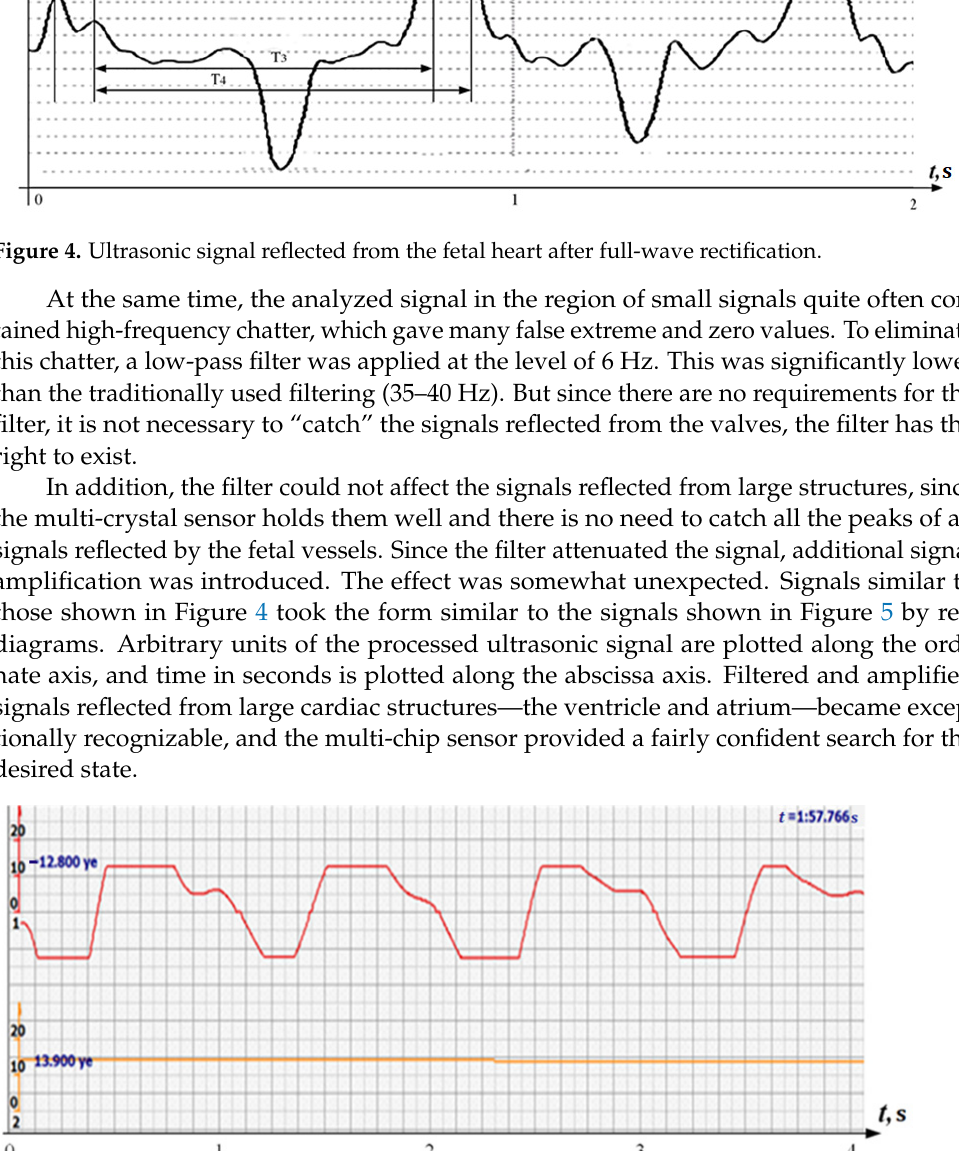
Figure 6. Diagram of heart rate calculations using the spectral method. Figure 7. Diagram of an ultrasonic signal during fetal movement.